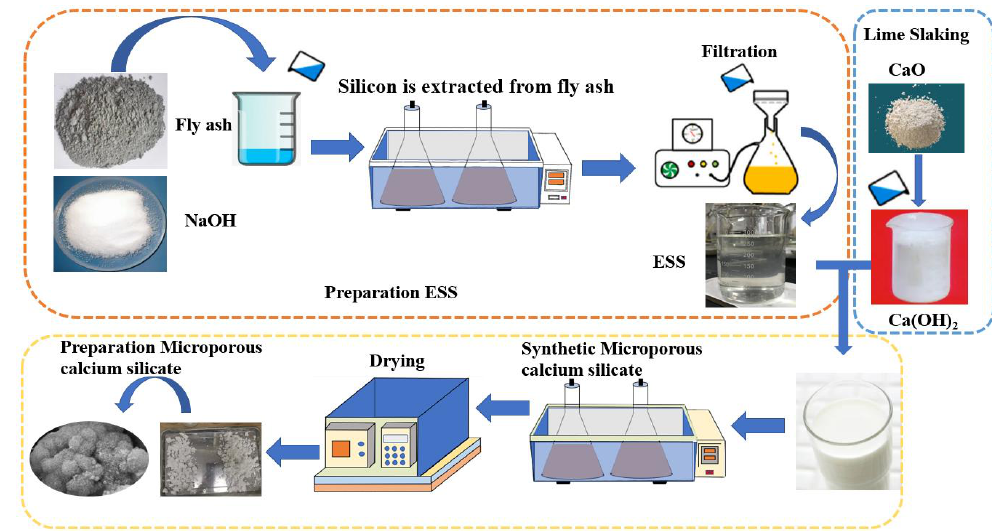
Figure 1. Preparation of microporous calcium silicate by the ESS form fly ash. Table 3. The composition of microporous calcium silicate was synthesized at different temperatures.